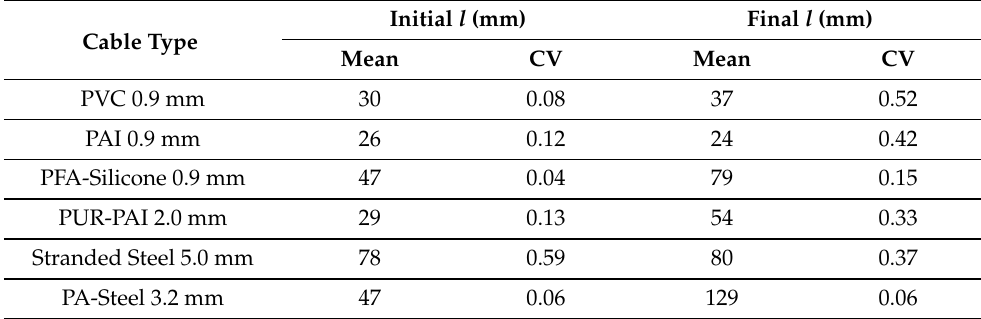
Table 3. Strain transfer length l for different types of cable.